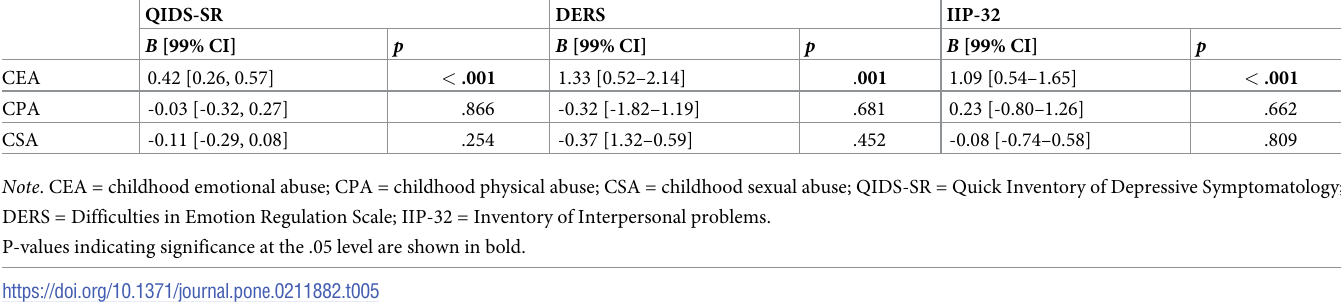
Table 5. Results of multiple linear regression analyses for predicting depressive symptoms, emotion dysregulation, and interpersonal problems in female college students ( N = 276). QIDS-SR DERS